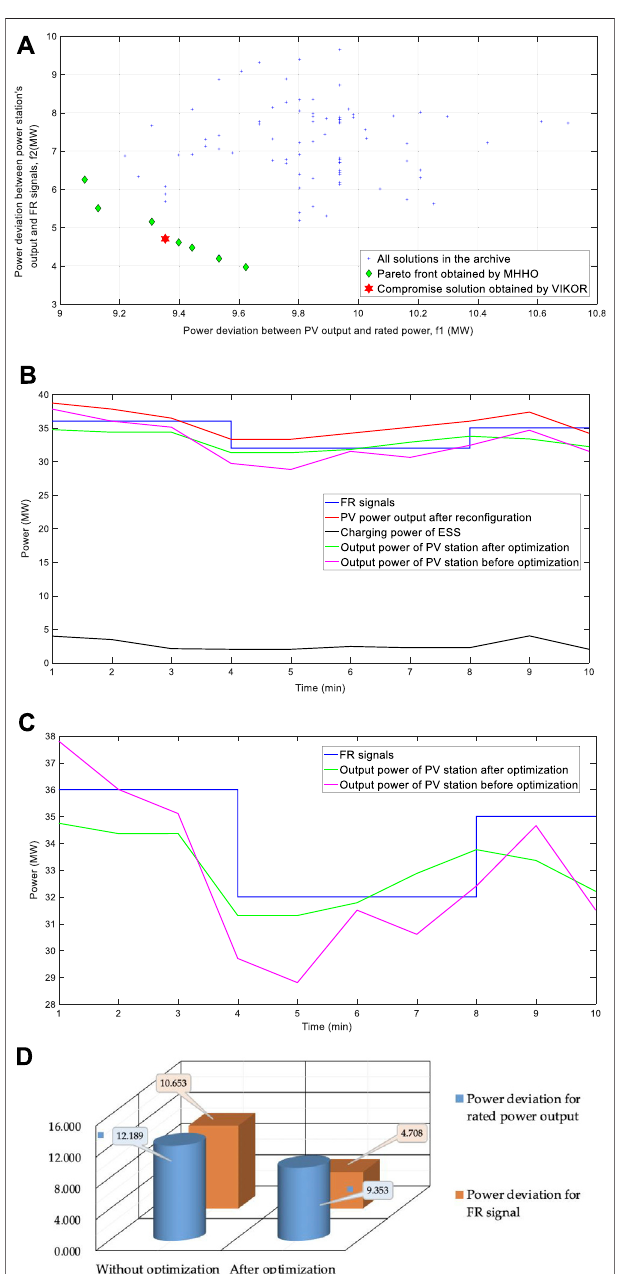
FIGURE 5 | The optimal solution and the comparison between the optimized results and original ones for time-varying FR signals test: (a) Pareto front obtained by MHHO and optimal compromise solution by VIKOR, (b) output results responding to FR signals, (c) power output curve of PV power station before and after optimization and (d) comparison of optimized power deviation with those of the original.